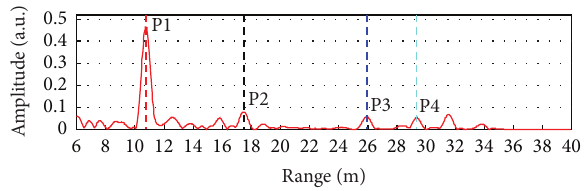
Figure 6: Radar plot relative to the measurement of spam no.